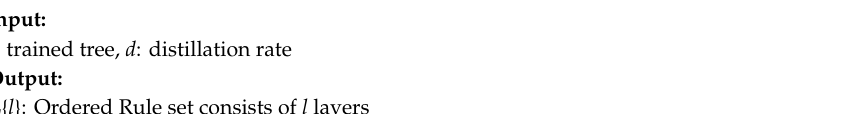
Algorithm 1: Overall procedure of rule